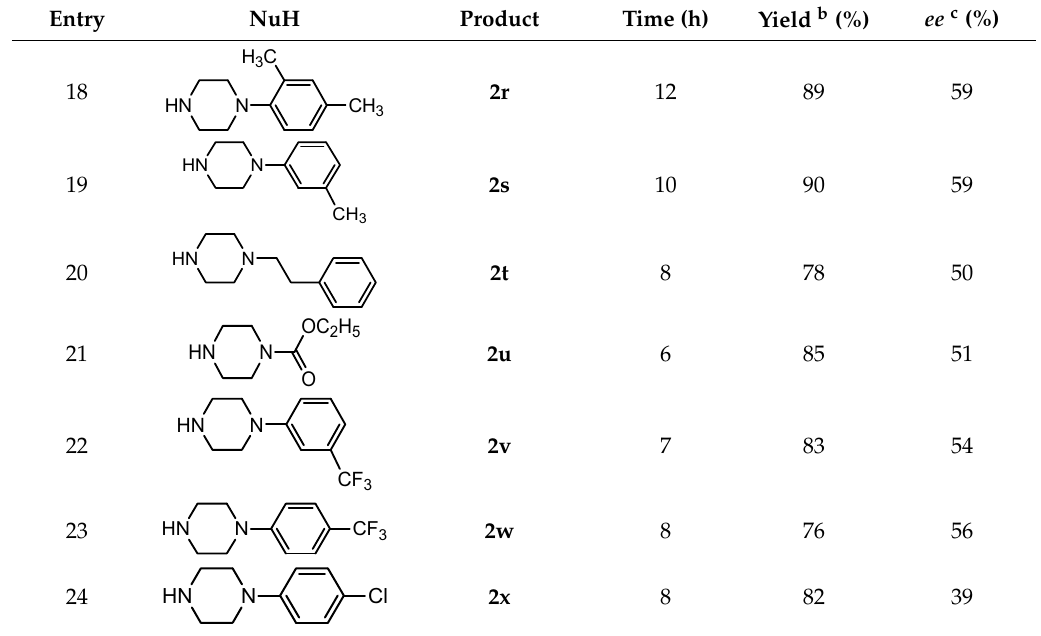
Table 4. Iridium-catalyzed asymmetric ring-opening of oxabenzonorbornadiene 1a with N -substituted